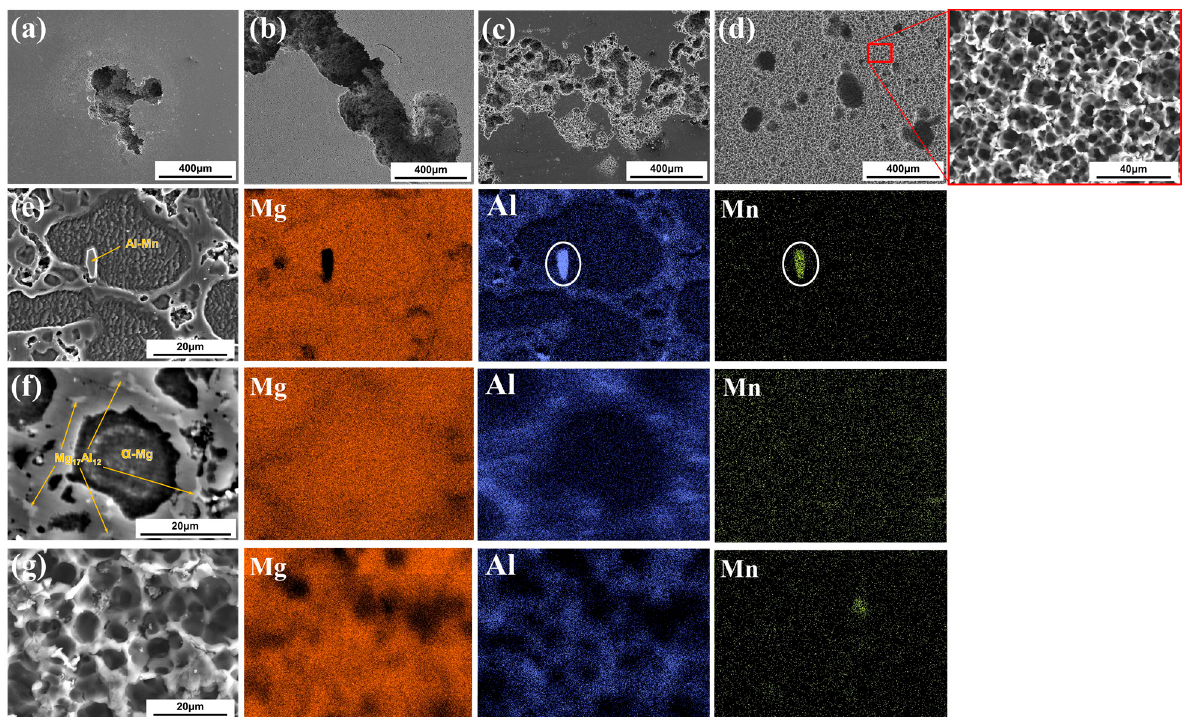
Figure 4. SEM images of HPDCed AM60 alloy under various immersion time: ( a ) 3 h; ( b ) 12 h; ( c ) 2 days; ( d ) 8 days; SEM with EDS mapping of HPDCed AM60 alloy after immersion for ( e ) 12 h; ( f ) 2 days; ( g ) 8 days, respectively.